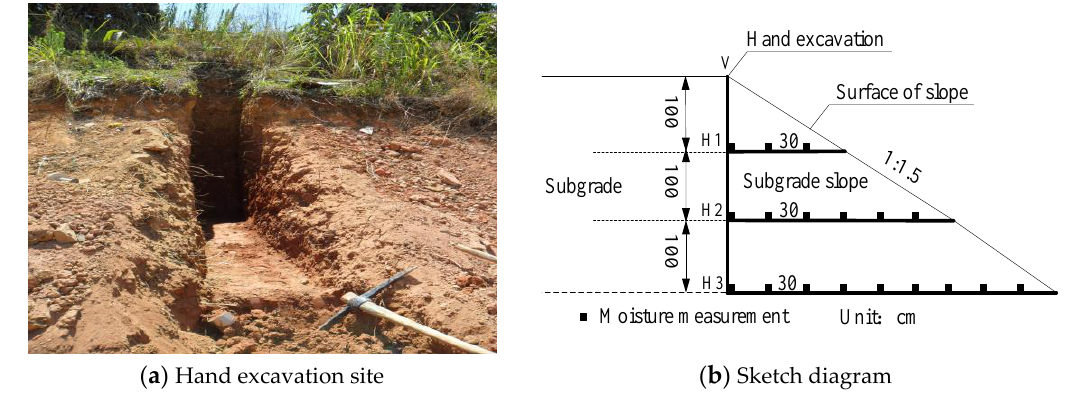
Figure 6. Hand excavation and sketch diagram. ( a ) Hand excavation site; ( b ) Sketch diagram.